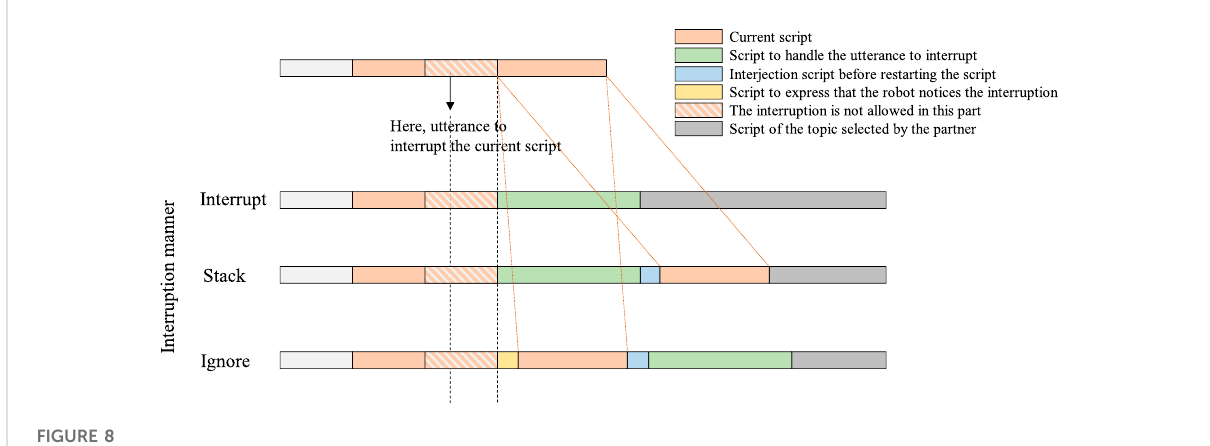
FIGURE 8 Pattern of handling the partner ’ s interruptive utterance.